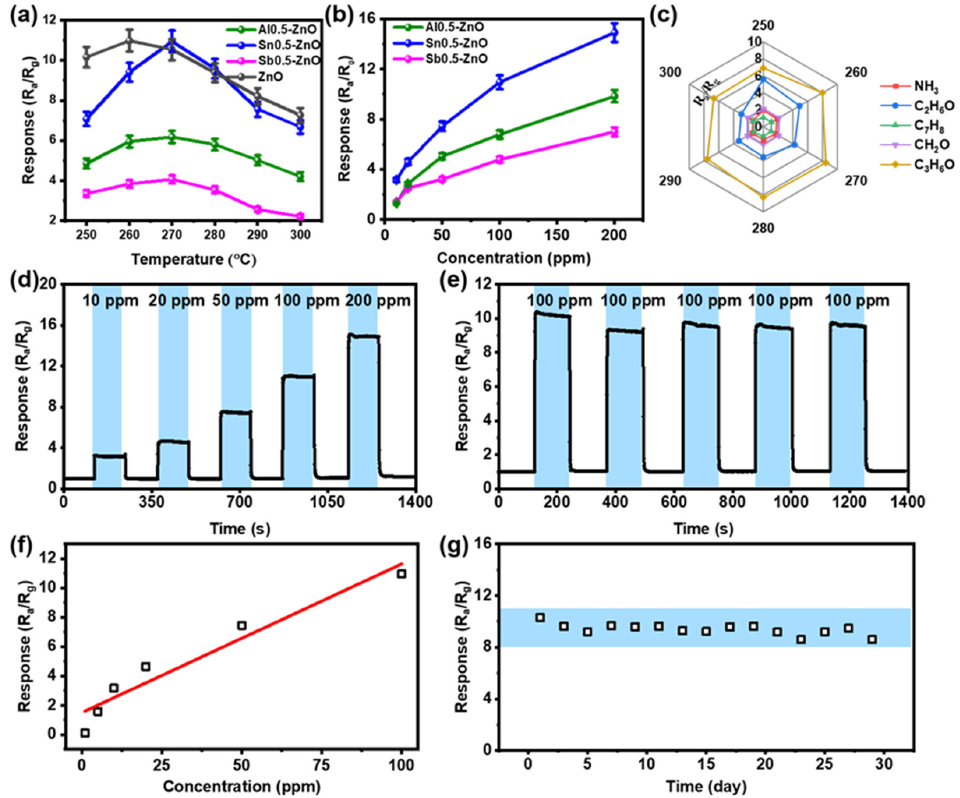
Figure 5. ( a ) The responses to 100 ppm acetone of various elements of doped M0.5-ZnO and ZnO samples at different temperatures (250–300 ◦ C). ( b ) The response of 0.5 mol% Al 3+ , Sn 4+ and Sb 5+ doped ZnO to different concentrations of acetone (10–200 ppm). ( c ) The response of the Sn0.5-ZnO to 100 ppm NH 3 , C 2 H 6 O, C 7 H 8 , CH 2 O, and C 3 H 6 O at different temperatures (250–300 ◦ C), respectively. ( d ) The response of the Sn0.5-ZnO to 10–200 ppm acetone at 270 ◦ C. ( e ) Five cycles of the response/recovery curve of the Sn0.5-ZnO sensor to 100 ppm acetone at 270 ◦ C. ( f ) Linear fitting curve for the response of the Sn0.5-ZnO to 1–100 ppm acetone at 270 ◦ C. ( g ) Long-term stability of the Sn0.5-ZnO after 30